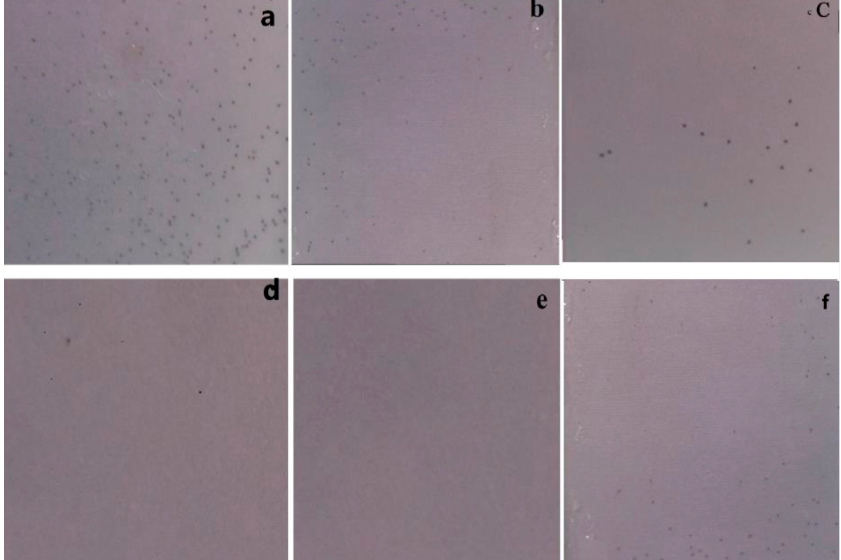
Figure 11. Surface appearance of the coatings after salt spray testing for 600 h: ( a ) neat epoxy coating; ( b ) 1.0% meso-TiO 2 coating; ( c ) 0.5% DA/meso-TiO 2 coating; ( d ) 0.7% DA/meso-TiO 2 coating; ( e ) 1.0% DA/meso-TiO 2 coating; and ( f ) 2.0% DA/meso-TiO 2